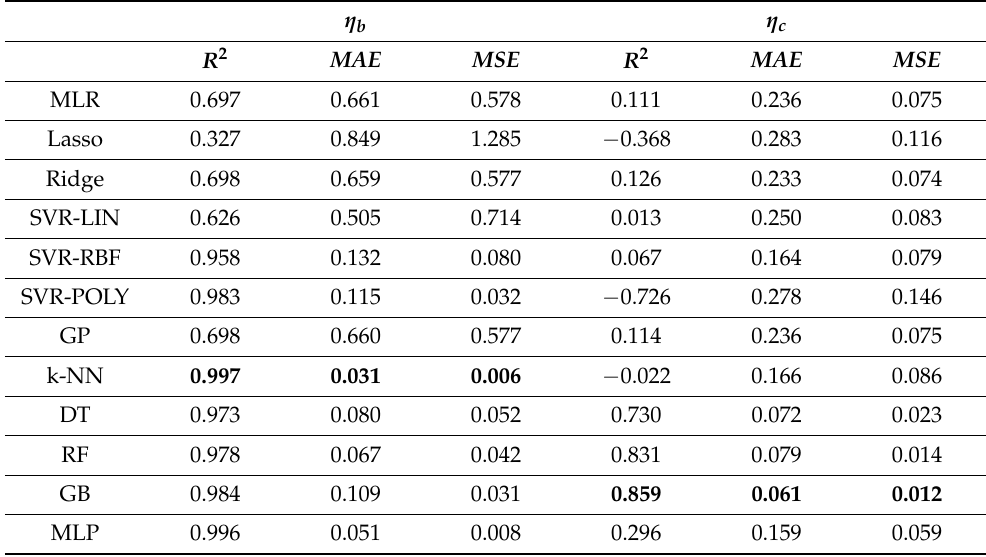
Table 2. Metrics and comparison of 12 ML algorithms for the datasets corresponding to simulation data for LJ bulk fluid shear viscosity ( η b ) and LJ liquid shear viscosity in Poiseuille flow ( η c ). Bold-type cells indicate the best metrics achieved for each